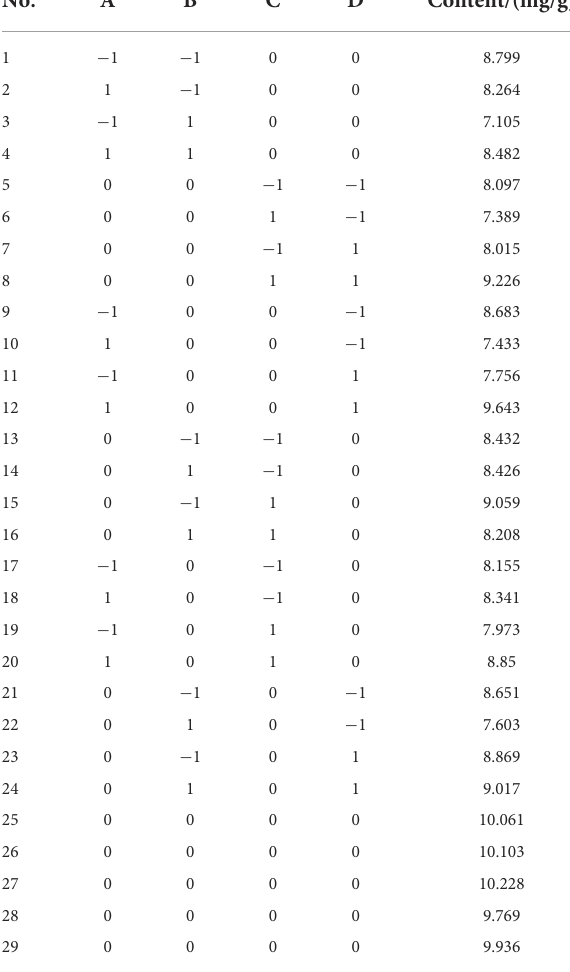
TABLE 2 RSM design and